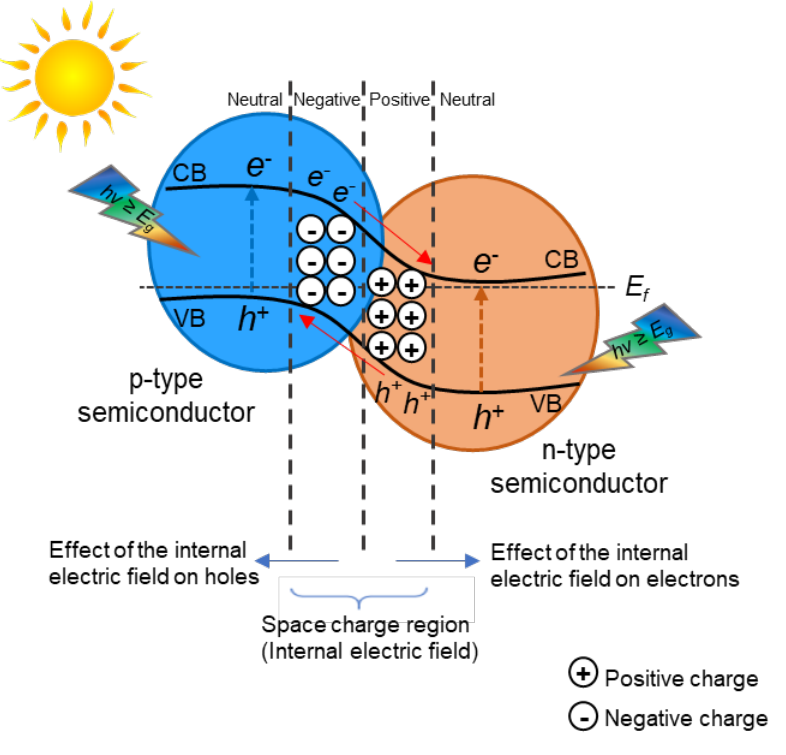
Figure 3. Schematic illustration of the electron–hole separation under the influence of the internal electric field of a p–n heterojunction photocatalyst under light irradiation. Adapted according to Refs. [18,19].